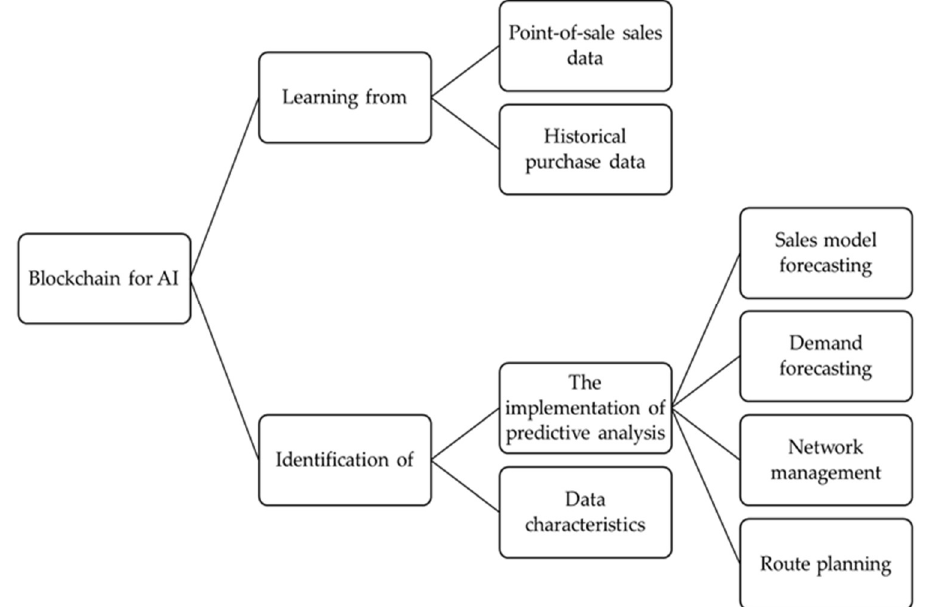
Figure 9. The applications of integrating AI and blockchains in supply chain.